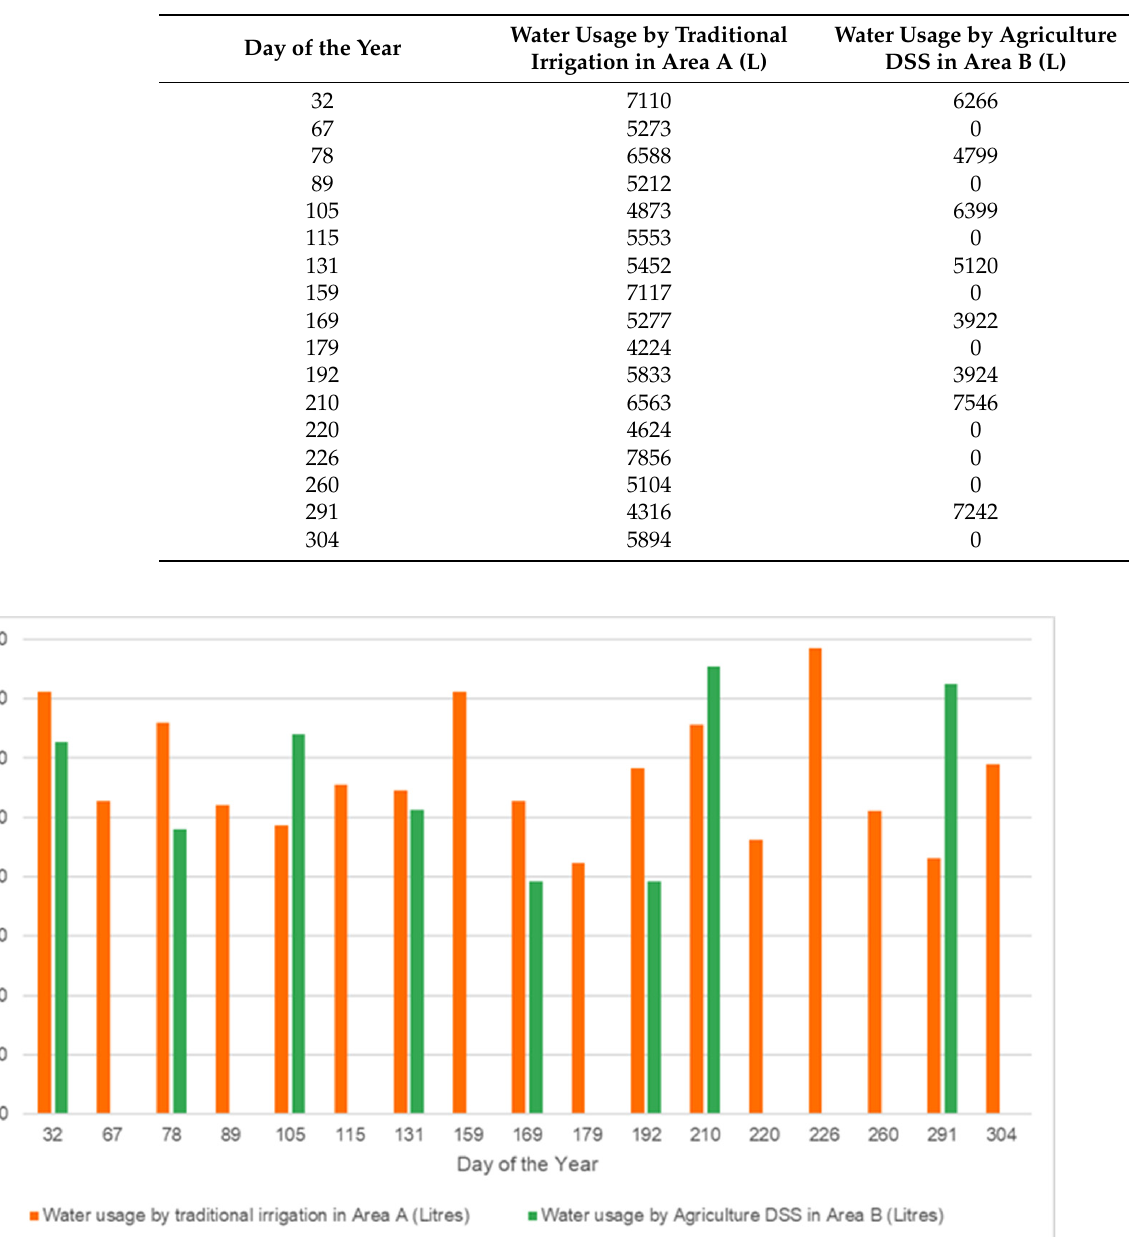
Table 2. Water usage efficiency by comparing irrigation frequency and amount of traditional and sensor-based system.